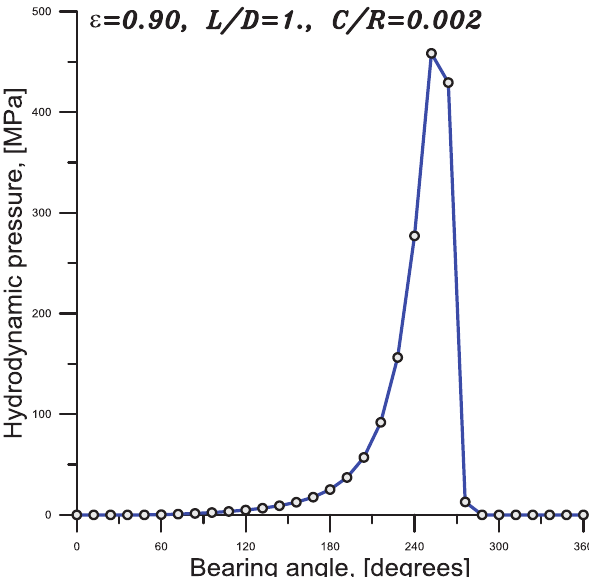
Fig. 4. Circumferential distribution of the hydrodynamic pressure fi eld exerted on the Bearing liner — fl uid fi lm